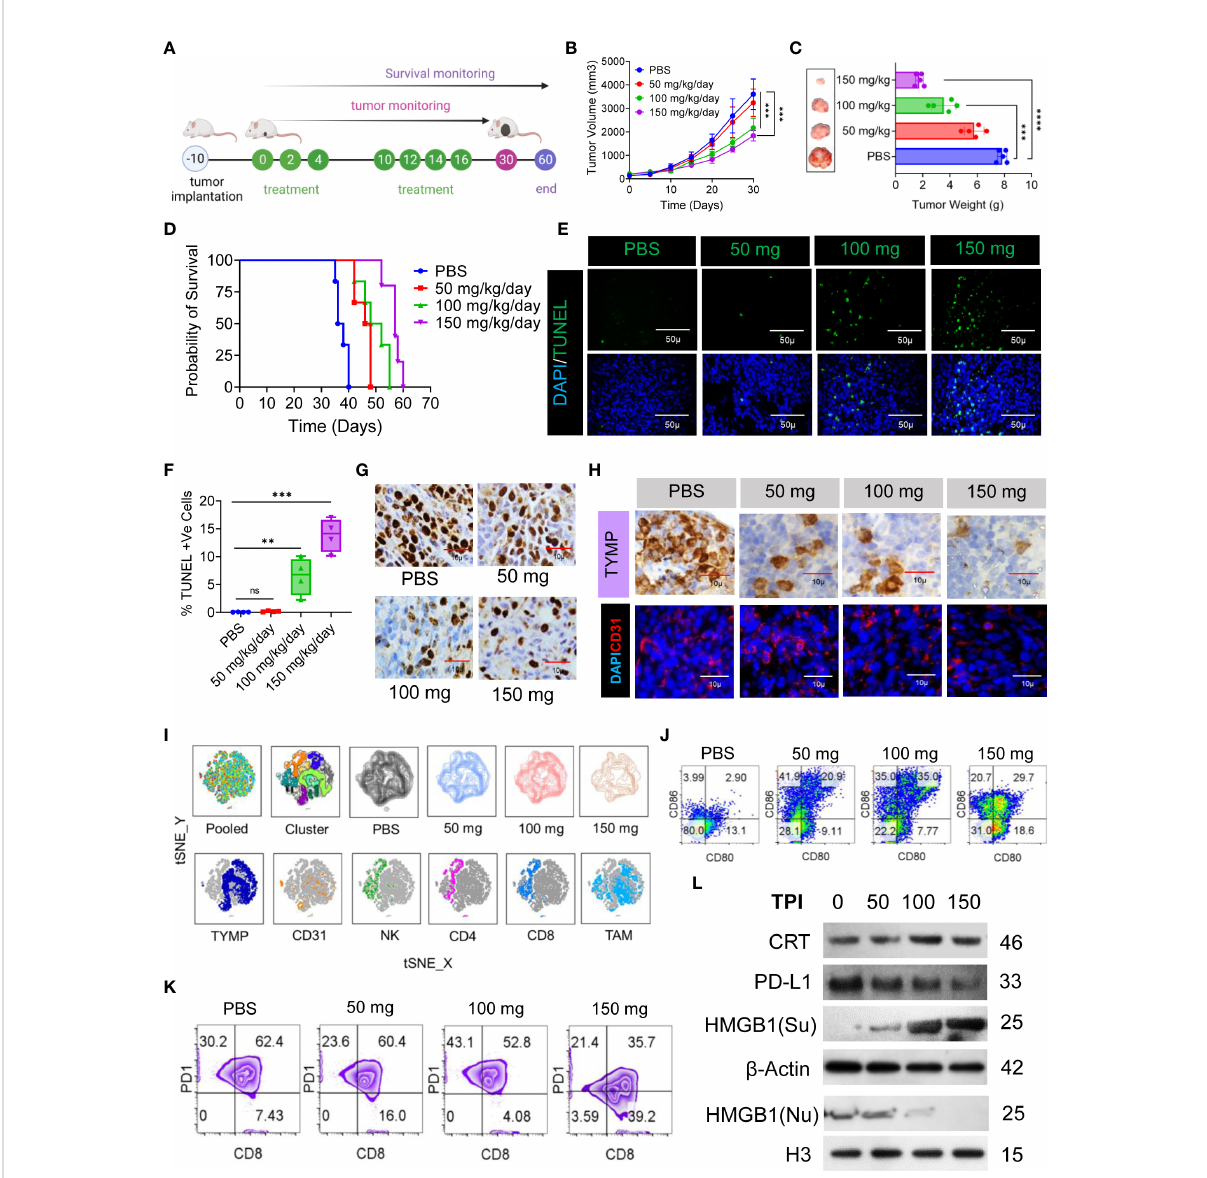
FIGURE 4 TPI monotherapy does not prolong CRC survival but induces ICD or downregulates PD-L1 in CRC cells, and ICD-associated DAMPs mediate DC maturation. (A) Schematic representation of the experimental setup to evaluate the effect of TPI monotherapy on the survival of CT-26 CRC- bearing mice (n = 6) (four independent repeats of survival assessment). (B) Tumor growth curves (n=6). (C) The tumor weight (mean ± SD, n=6) of each group and representative images of the tumors dissected on day 30; n = 3 mice. (D) Kaplan – Meier analysis of the mice; n = 6 mice. Median survival for PBS (37 days), 50 mg kg -1 bw (47 days), 100 mg kg -1 bw (50 days), and 150 mg kg -1 bw (57 days), p = <0.0001]. (E) TUNEL staining of the tumor sections dissected on day 30; green: TUNEL; blue: DAPI; scale bars: 50 m m; to con fi rm the results, the experiment was repeated independently three times. (F) Boxes represent interquartile ranges (IQRs) of the percentage of TUNEL-positive cells. The experiment was performed in triplicate with four mice, and the results are presented as the mean±SD. (G) Representative tumor tissue sections from three mice showing immunostaining for Ki-67. The bar indicates 10µm. (H) IHC analysis of TYMP (top) and immuno fl uorescence analysis of CD31 (bottom) in CRC tumors at day 30 of the indicated groups. (I) Global tSNE projection of TILs in the polled and indicated treatment groups (upper panel) and tSNE maps showing the expression level and the distribution of each indicated marker among the identi fi ed clusters (lower panel). TYMP (deep blue), CD31 (orange), NK cells (green), CD4 + T cells (pink), CD8 + T cells (light blue) and TAMs (sky blue) in TILs for all treatment groups pooled, concatenated and overlaid. (J) ICD-associated DAMP-mediated DC maturation determined by fl ow cytometry (CD11c +- gated CD80 + CD86 + ), n=3. (K) Representative PD1 expression in CD3 + /CD8 + -gated TILs. (L) Western blot analysis of CRT, HMGB1 and PD-L1 expression in tumor tissue and its fold increase or decrease compared to the untreated control. b -Actin and H3 were used as loading controls for the cytoplasmic and nuclear fractions, respectively, n=3. Unless otherwise noted, the data are presented as independent biological triplicates. In vivo studies were repeated independently fi ve times to con fi rm the results. ns, not signi fi cant, **p < 0.01, ***p < 0.001, and ****p <